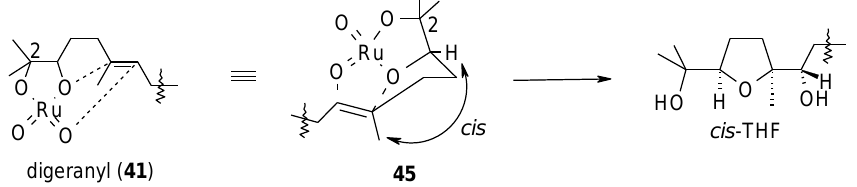
Figure 3. Model for the cis -selective first cyclization of digeranyl [52,53,60,61,106–111].